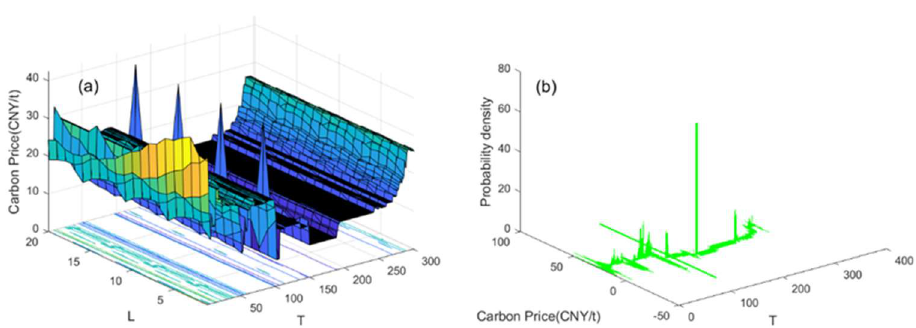
Figure A6. Price data and probability density distribution of carbon market in Shenzhen, ( a ) evolution of daily closing price data; ( b ) distribution of probability density.